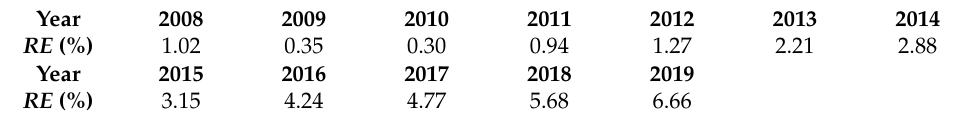
Table 3. Relative errors in percentage ( RE ) for the life expectancy at birth in Spain in the 2008–2019